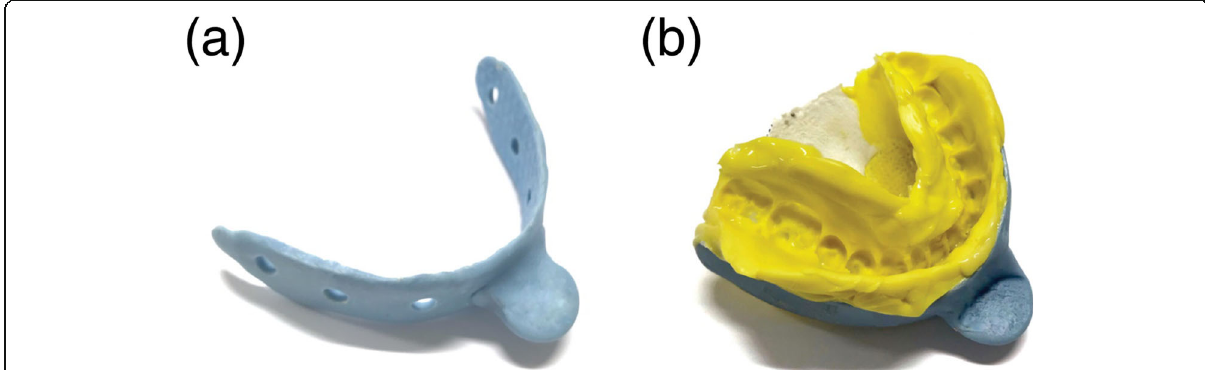
Fig. 2 VPS impression pattern. a The customized tray used to take VPS impression pattern passing along the buccal side of the upper and lower arches in a “ U ” form to provide support to the impression. b The lower view of VPS impression pattern together with the customized tray and the lower dental arch together with the tongue shape can be